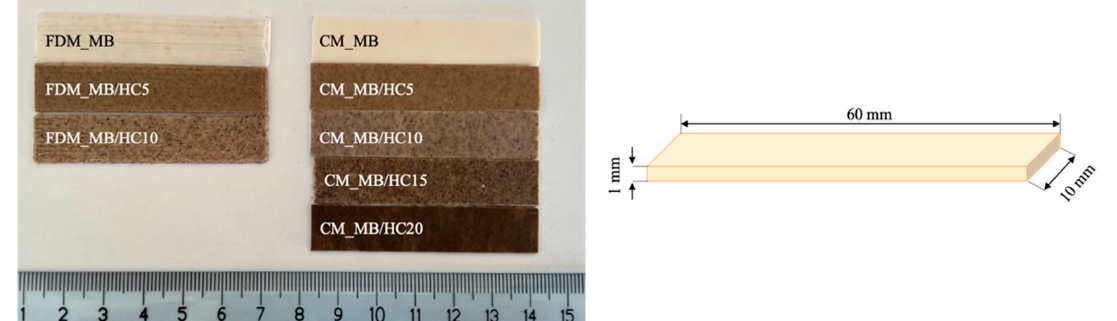
Figure 1. FDM- and CM-obtained samples.